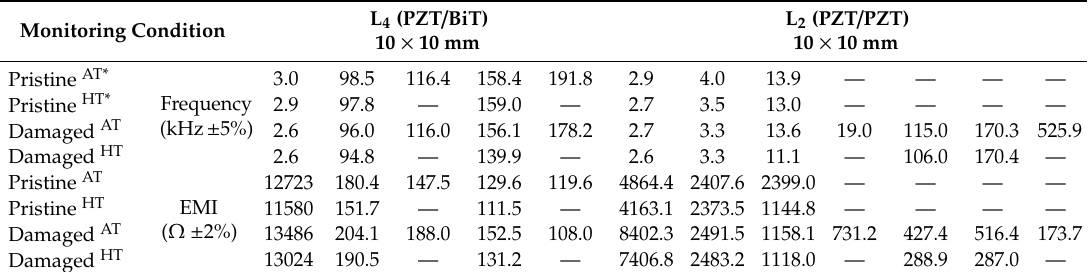
Figure 8. Real and imaginary EMI for the blade L 2 , frequency sweep at 1–600 kHz using the transceiver circuit at 200 ◦ C; ( a ) pristine blade and ( b ) damaged blade. Table 2. Anti-resonance frequency and EMI of the blades L 2 and L 4 at 20 and 200 ◦ C, using the transceiver